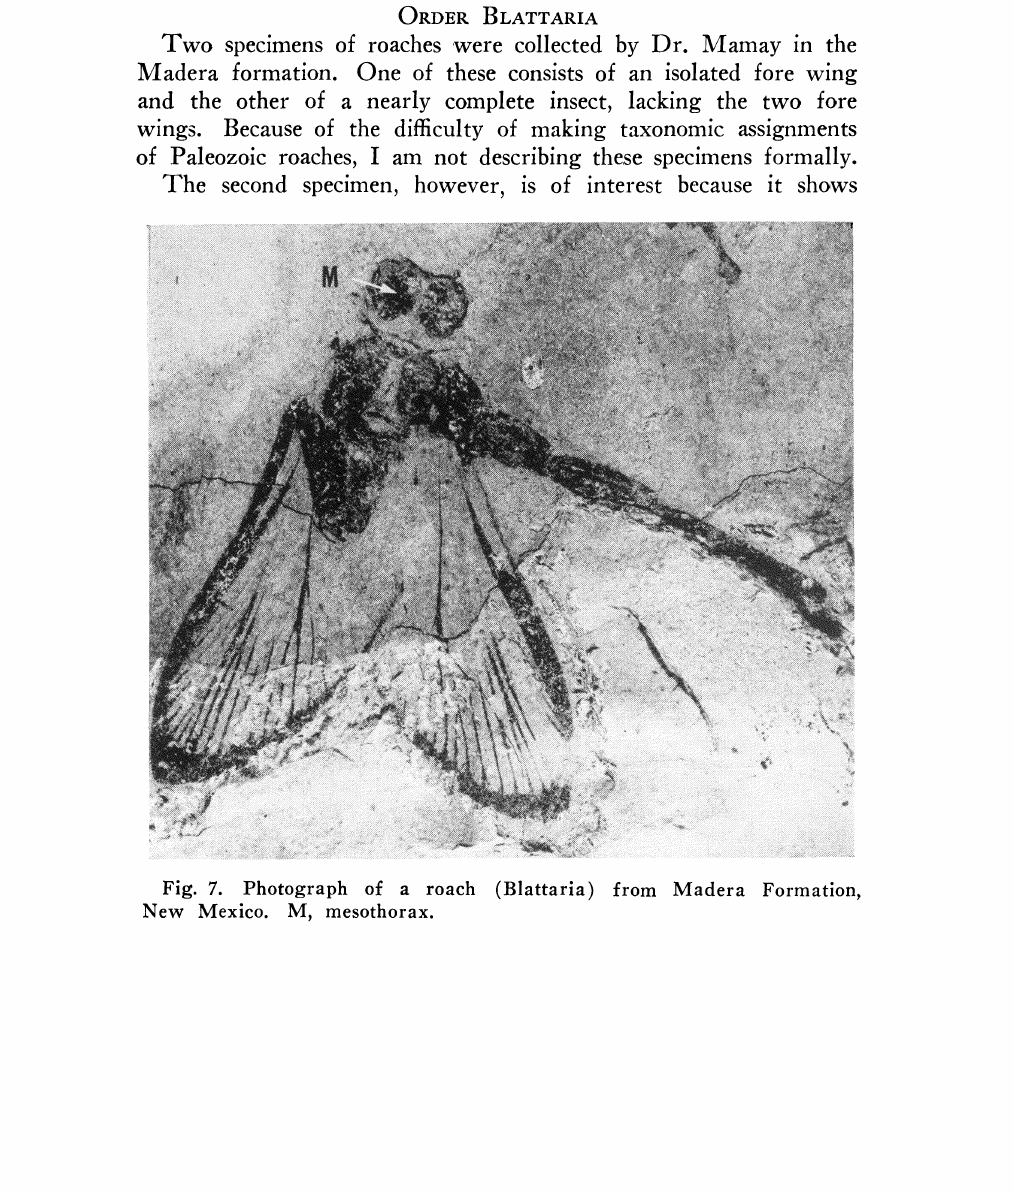
Fig. 7. Photograph of a roach (Blattaria) from Madera Formation, New Mexico. M,